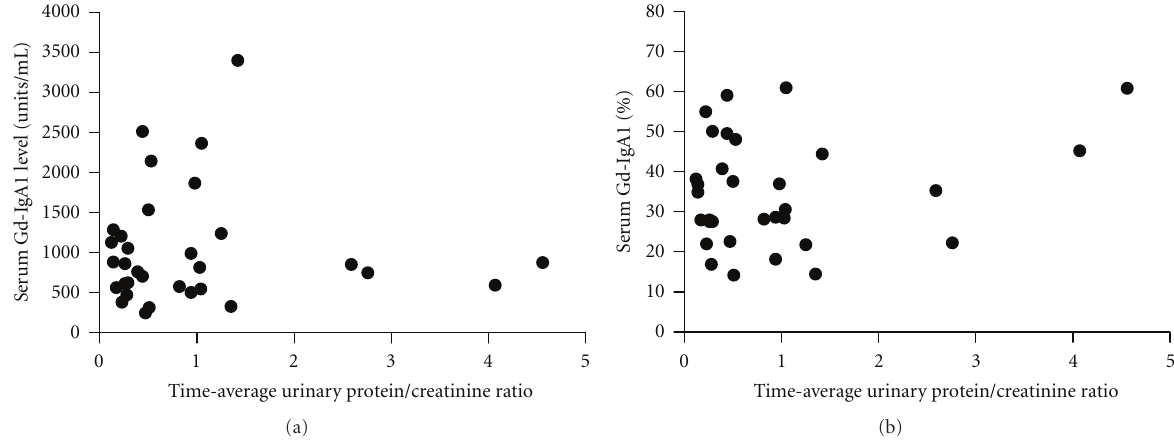
Figure 3: Time-average urinary protein/creatinine ratios. (a) Plotted against average serum Gd-IgA1 levels. Spearman’s rank correlation is r = 0 . 06, P = 0 . 75. (b) Plotted against serum percent Gd-IgA1 levels. Spearman’s rank correlation is r = 0 . 04, P = 0 .